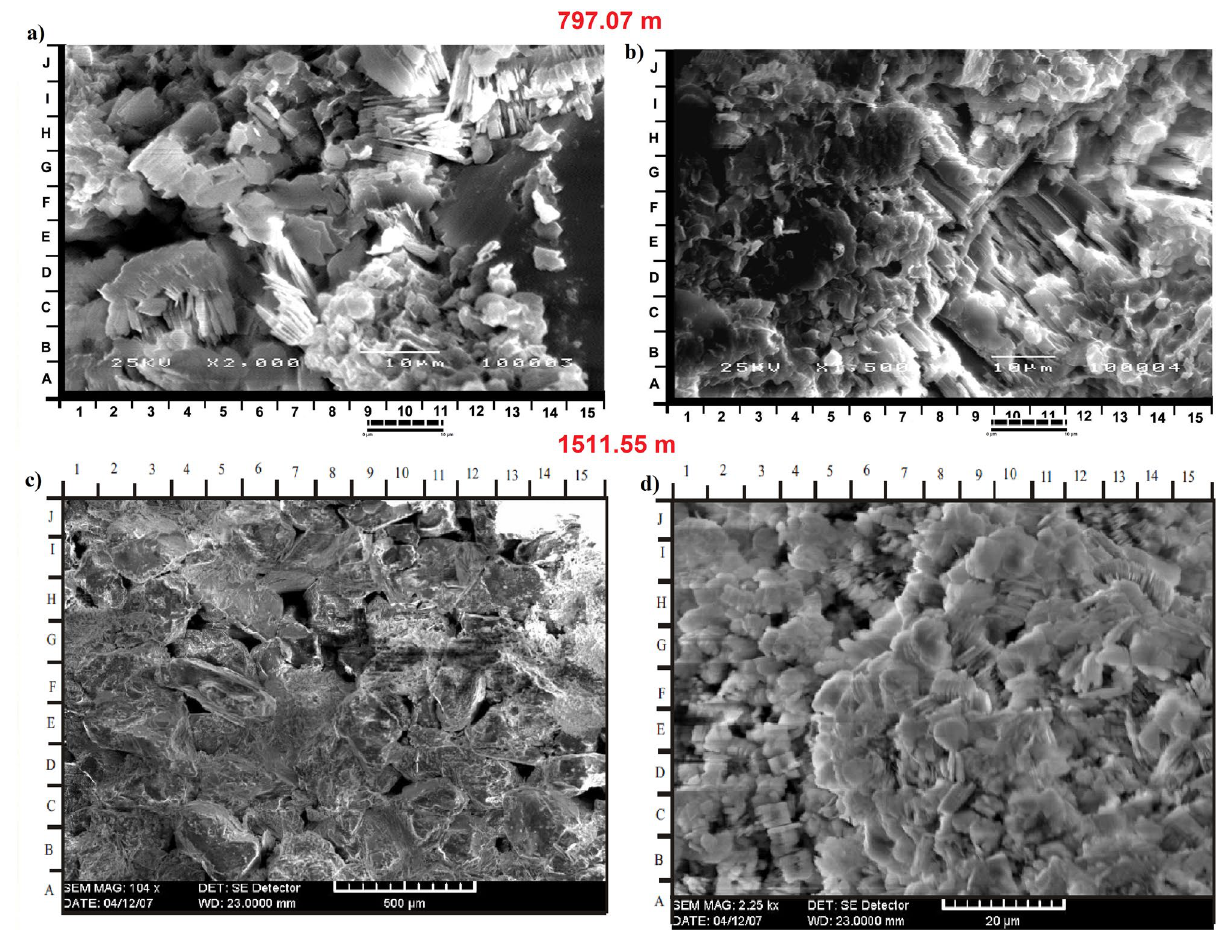
Figure 8. (a-d ) SEM result showing kaolinite and chlorite minerals. Detrital plates of kaolinite partially filling some pores and partially covering some detrital grains ( a : G9 and 11b: D14-15) which indicated as micropores. Well crystallized pore filling kaolinite booklets ( a : G9), showing vermi-form texture ( a : C4, G3-4, J11) of partly corroded pseudohexagonal basal plates ( a : E-F7 and d : F/G 14–15) have been observed. Minor poorly crystallized ribbon-like illites ( b , D-E12-13, F-G2) locally replace clay matrix. Some clusters of disc-like plates of chlorite were also observed ( d : H-i samples (e.g. Fig. 8). This was done to clarify the diagenetic effects of the clay minerals on the reservoir quality. Table 6 shows the XRD analysis result and is further described below: Kaolinite. Kaolinite were diagnosed by 7.1 Å and 3.58 Å peaks in the dried XRD pattern which are unaltered using ethylene glycol treatment, although it was completely removed after being heated to a temperature of 550 °C 30–32 . The amount of kaolinite observed in all examined samples in amounts ranging ranges between 47.5– 93.5% (Table 6). Kaolinite is formed mainly in surficial environments through a series of pedogenetic events 29 .